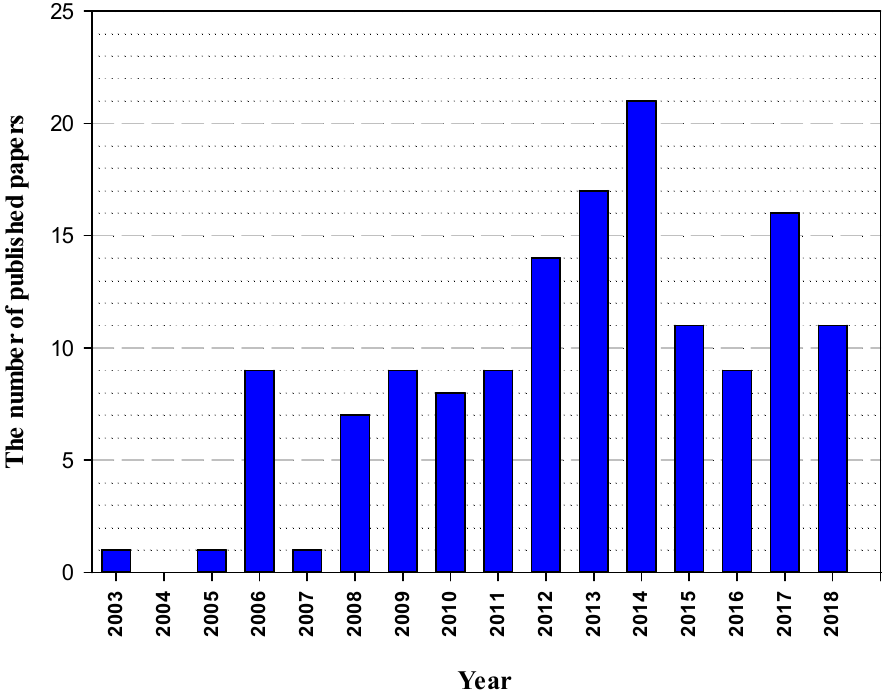
Figure 1. Indexed papers in Scopus (12 September 2018) using the keywords: nano, impact and composite laminate.